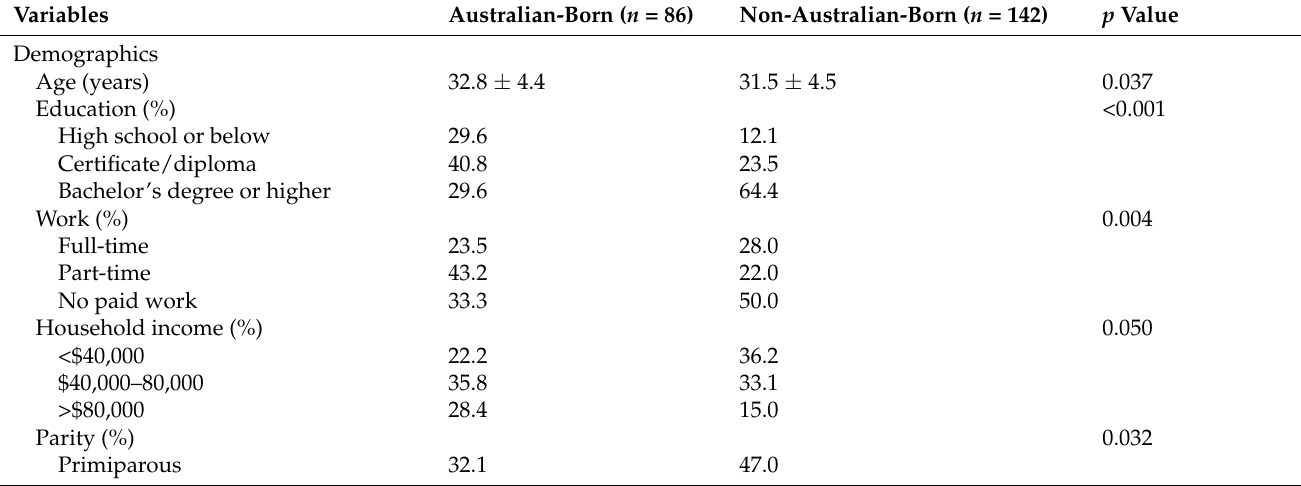
Table 1. Baseline characteristics of